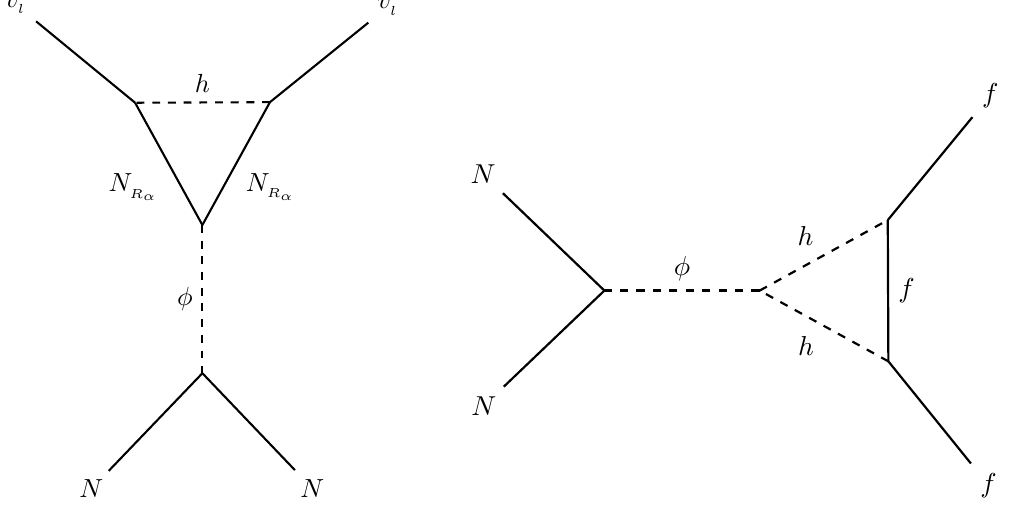
Figure 6 . Left: the DM annihilation to SM neutrinos is shown, where h is the Higgs field. Right: the DM-SM fermion scattering is